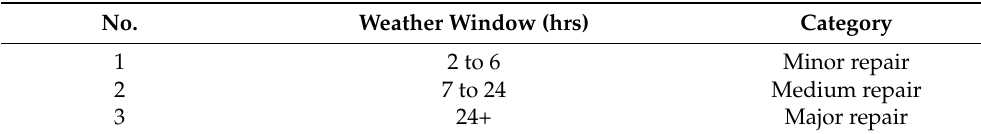
Table 3. Weather windows required for